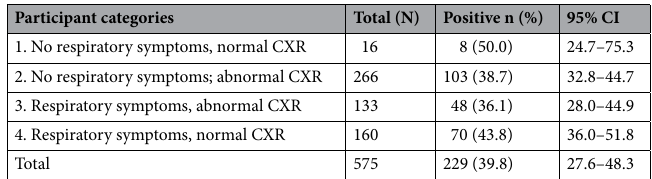
Table 3. Prevalence of NTM across four participant groups in study population n = 229.